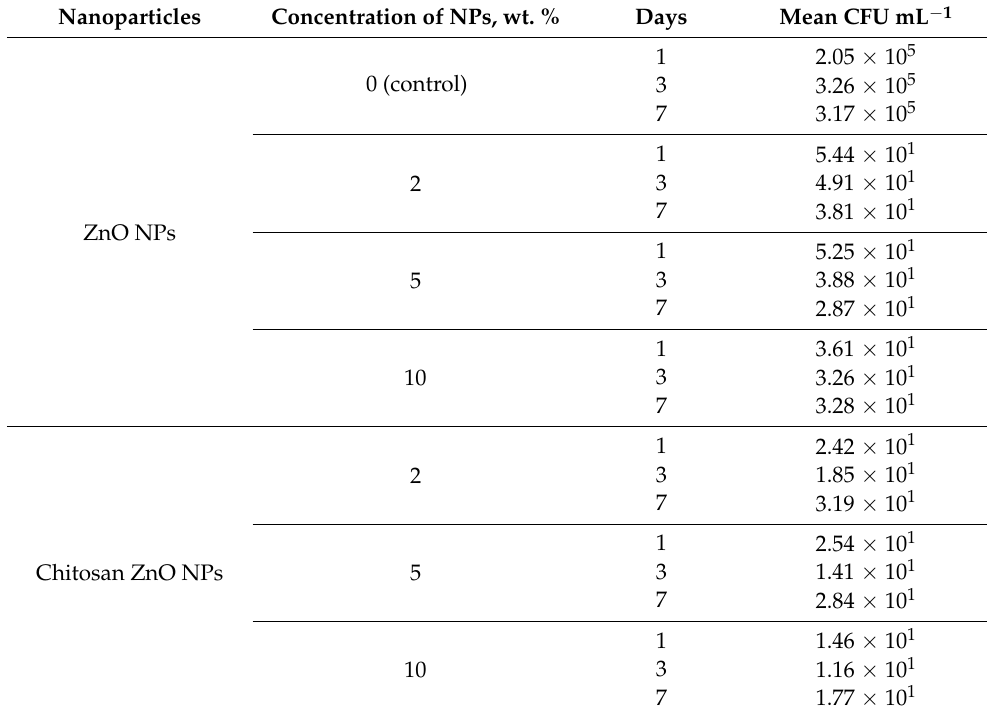
Table 4. Anti-cariogenic activity of adhesive disks containing different concentrations of ZnO NPs and chitosan ZnO NPs. Nanoparticles Concentration of NPs, wt.